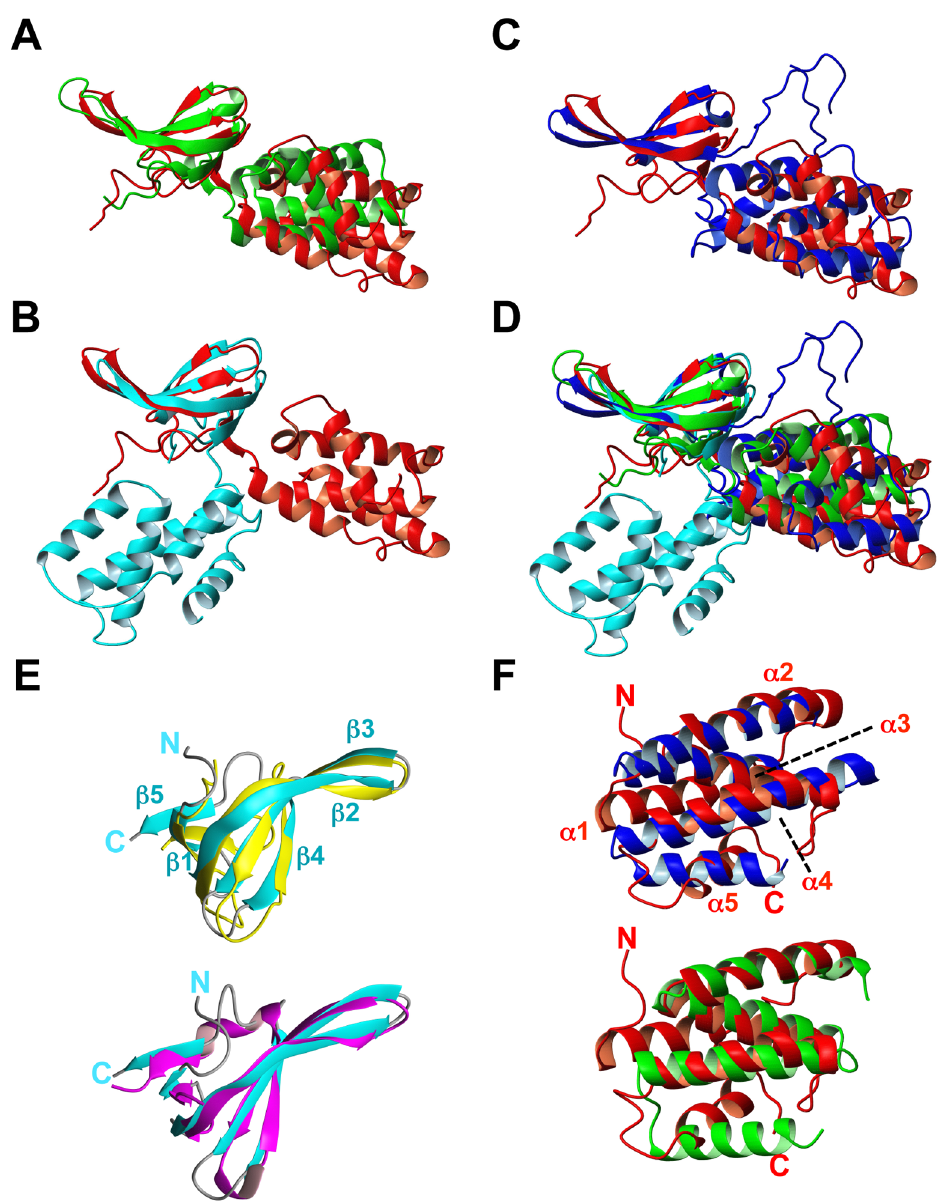
Figure 3. Structural comparisons with M.xanthus CdnL NMR structure. Backbone overlay of the CdnL NMR structure (red) onto the crystal structures of ( A ): TtCdnL (green; PDB: 4L5G); ( B ) one unit in the MtCdnL domain-swapped dimer (blue; PDB: 4ILU); ( C ) MtCdnL in complex with the RNAP b -lobe domain (cyan; PDB: 4KBM); ( D ) all four structures. The overlay shown was generated with optimal (maximum) superposition of the N- terminal domains of each structure. ( E ) Backbone overlay of CdnLNt (cyan; left) onto: (top) TtCdnLNt (gold; PDB ID: 2lqK); (bottom) E. coli TRCF-RID (magenta; PDB ID: 2eyq). ( F ) Backbone overlay of CdnLCt (red) onto the TPR domains of: (top) FK506-binding protein (blue; PDB ID: 1kt0); (bottom) CadC pd (green; PDB ID: 3ly8). Structures were generated with MOLMOL.